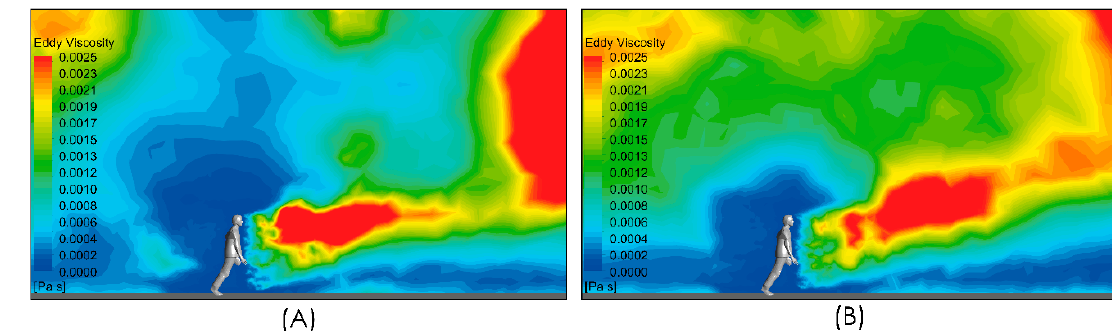
Figure 8. Side view of subgrid viscosity distribution in the near person zone. Moderate intensity airflow of 2 m/s ( A ) and intense airflow of 4 m/s ( B ).